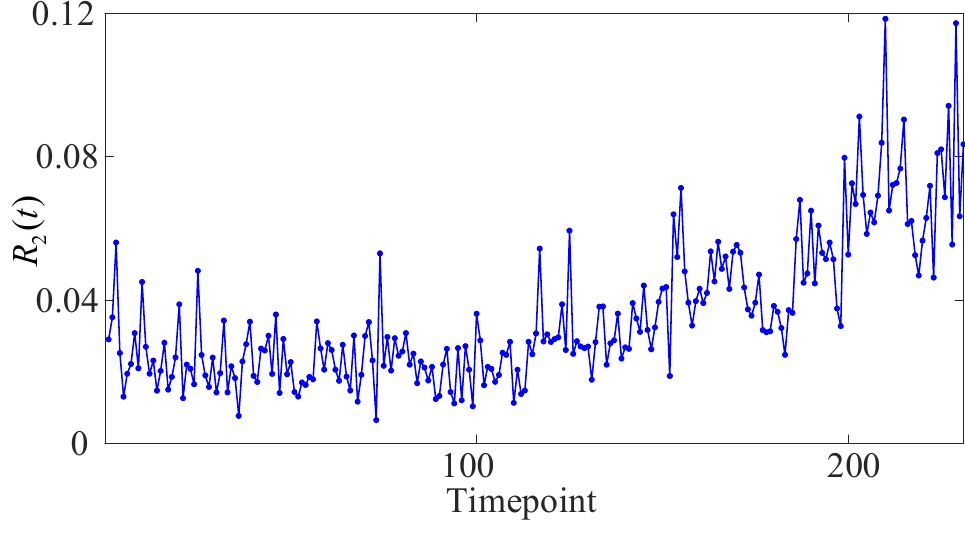
Figure 10. The sequence of FDI R 2 ( t )